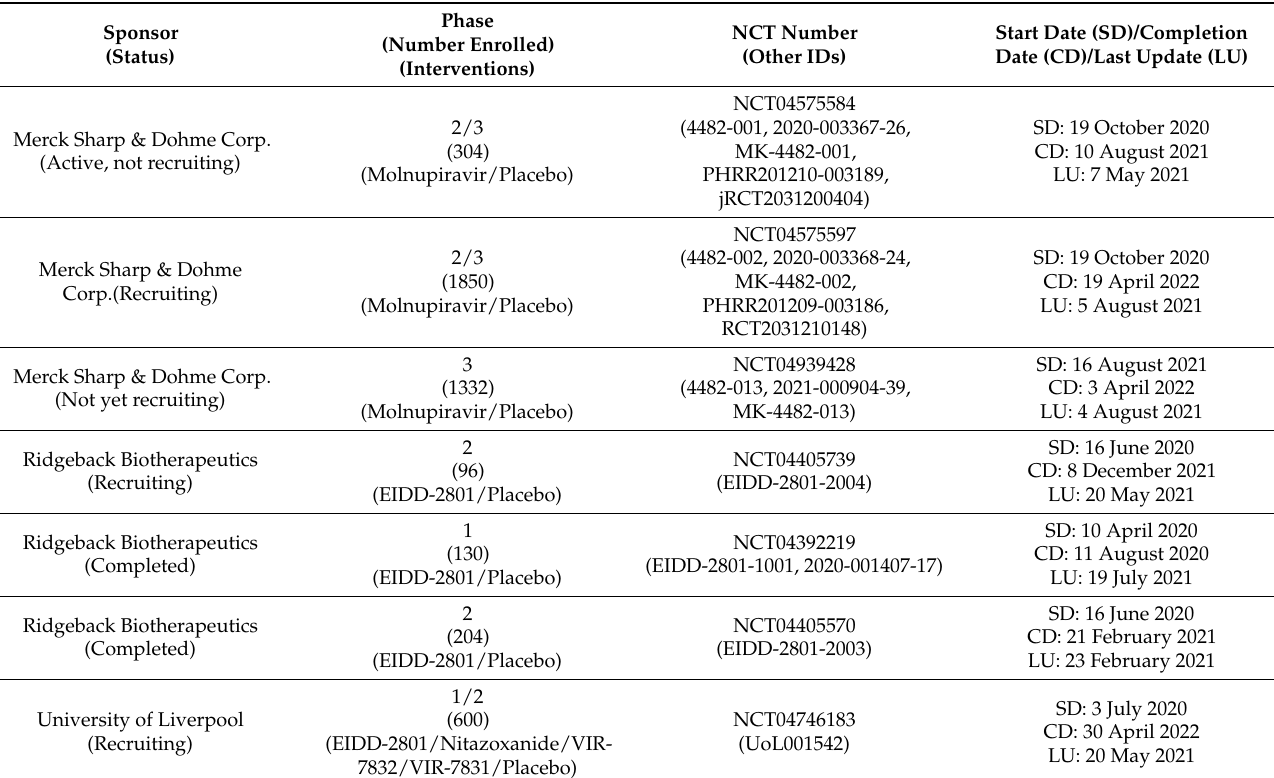
Table 3. Interventional randomized clinical trials on molnupiravir (EIDD-2801, MK-4482) for the treatment of COVID-19. Sponsor